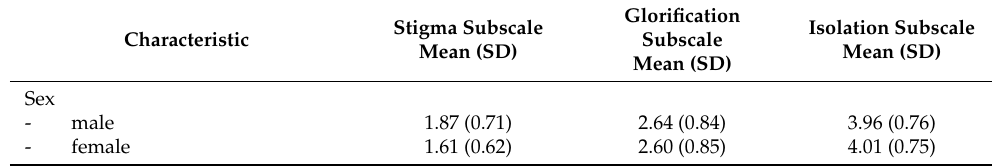
Table 2. Stigma of suicide scale summary scores across demographic